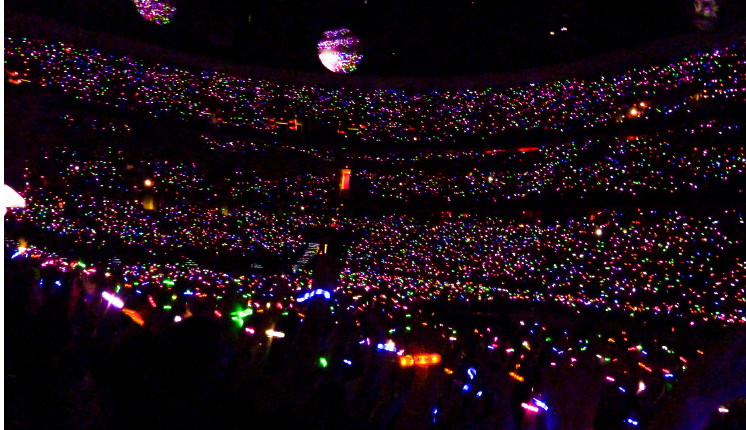
Figure 2. Concert of Coldplay at Verizon Center. Spectators wear LED wristbands manufactured by Xylobands (http://xylobands.com). Author: Matthew Straubmuller; license: https://creativecommons. org/licenses/by/2.0/; source: